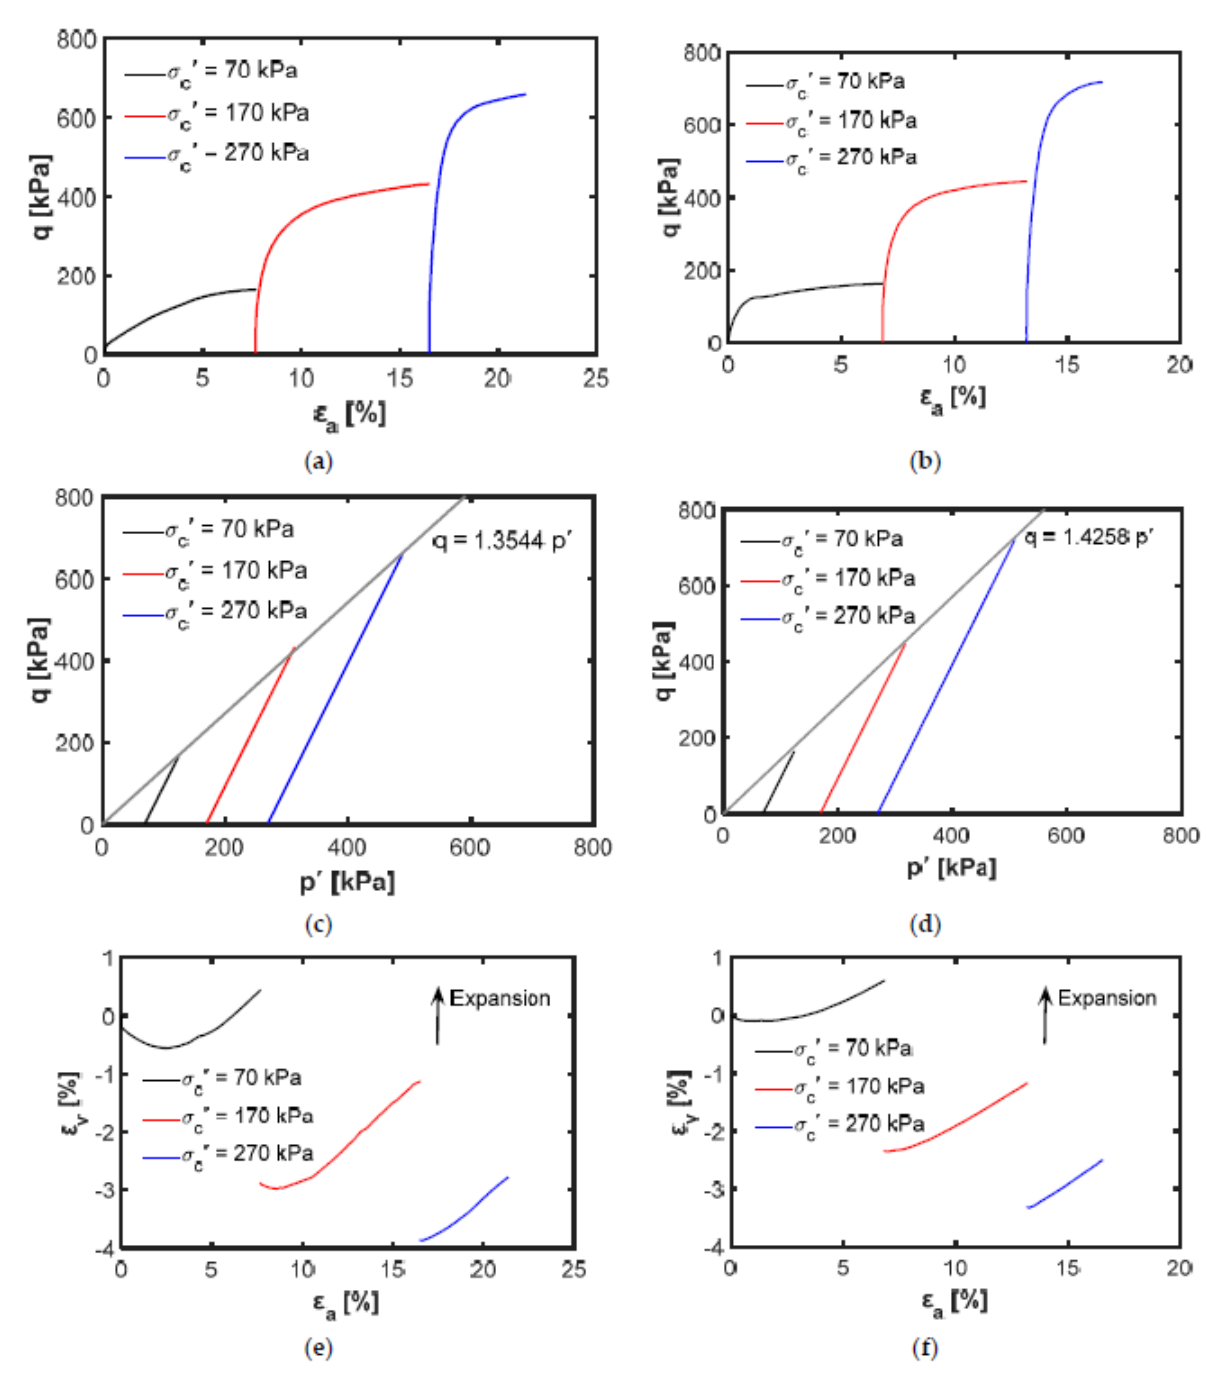
Figure 11. Shearing phase plots at T = 40 ◦ C of: ( a , c , e ) oM; ( b , d , f )